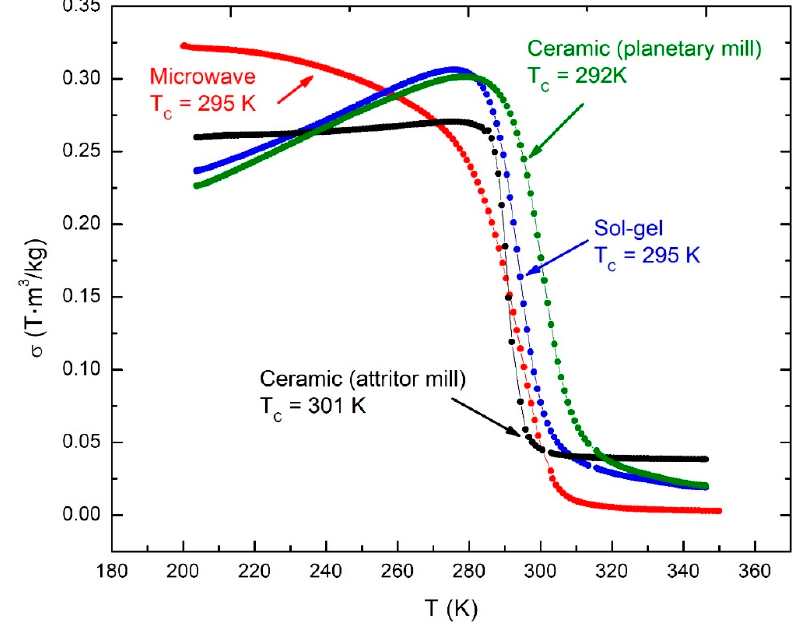
Figure 4. Thermomagnetic curves of lanthanum-calcium-strontium manganites, manufactured by different routes. These curves were measured with an applied magnetic field of 7.0 mT.